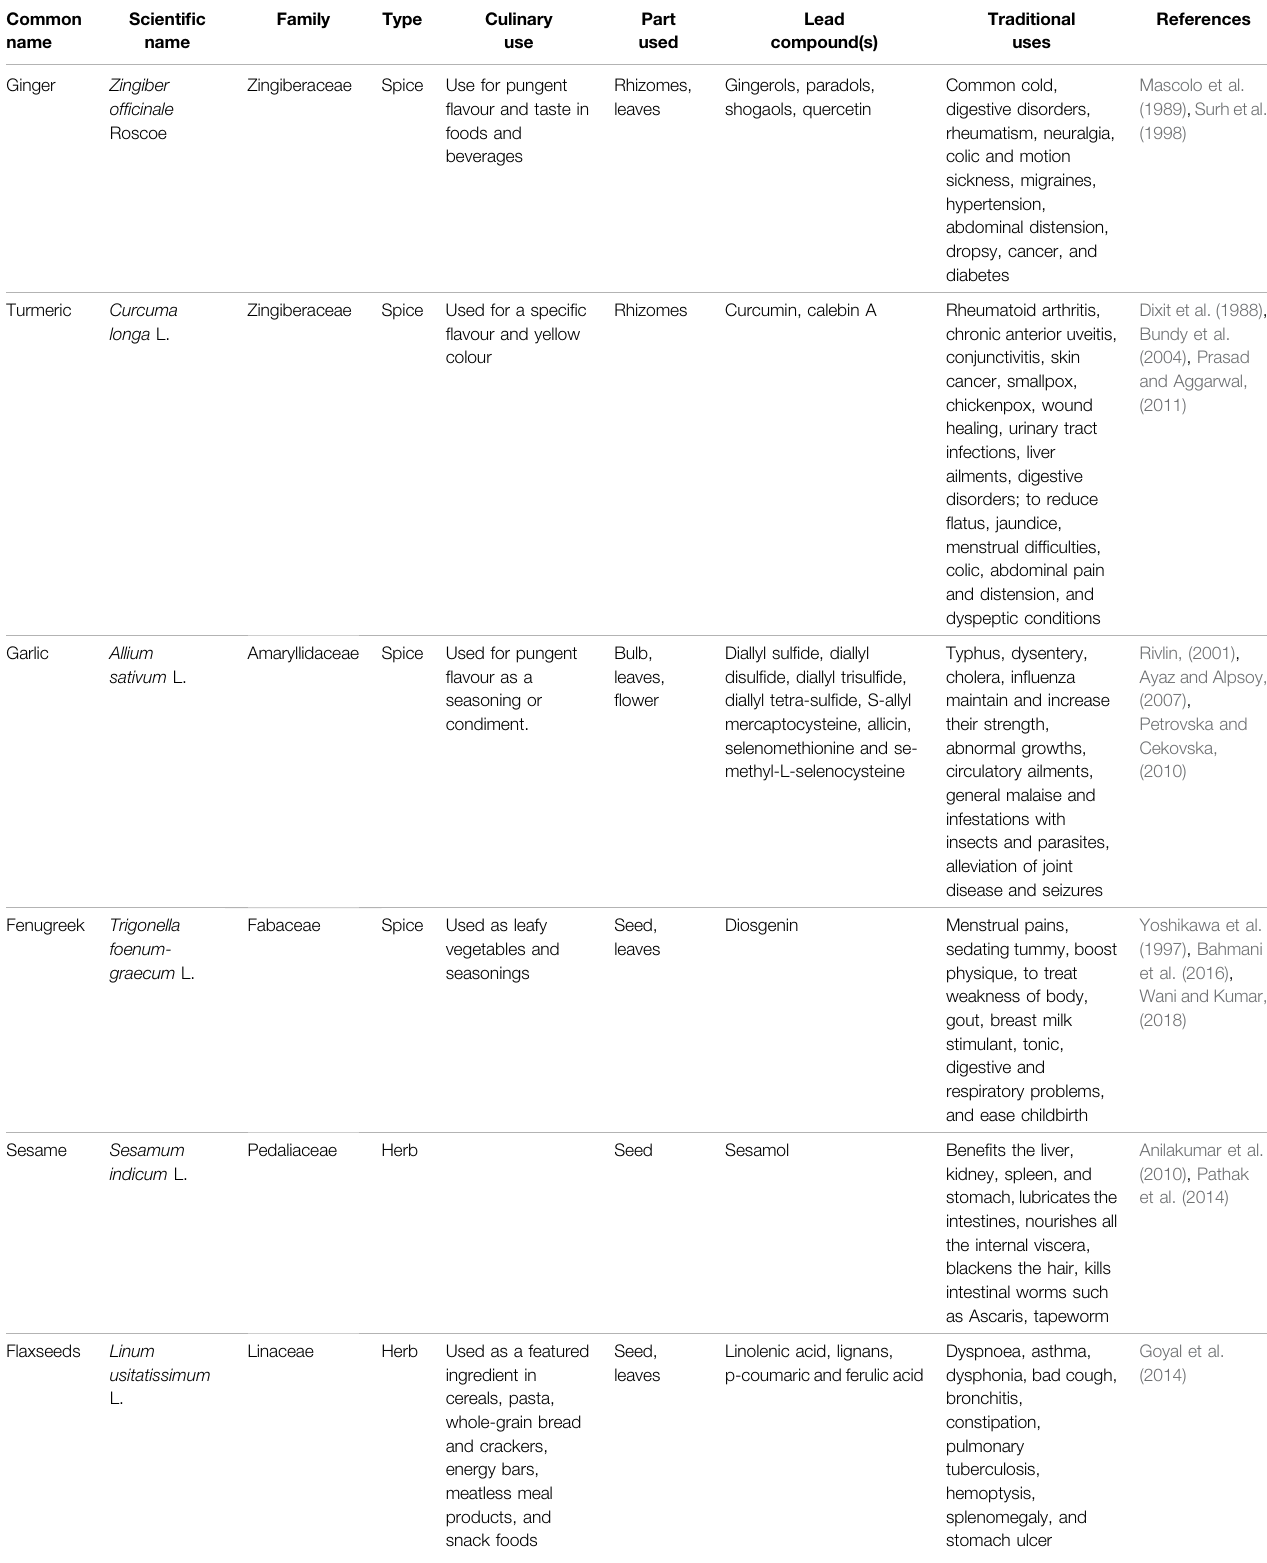
TABLE 1 | Traditional uses of herb and spice along with their scienti fi c name, family, culinary uses, part used, and lead